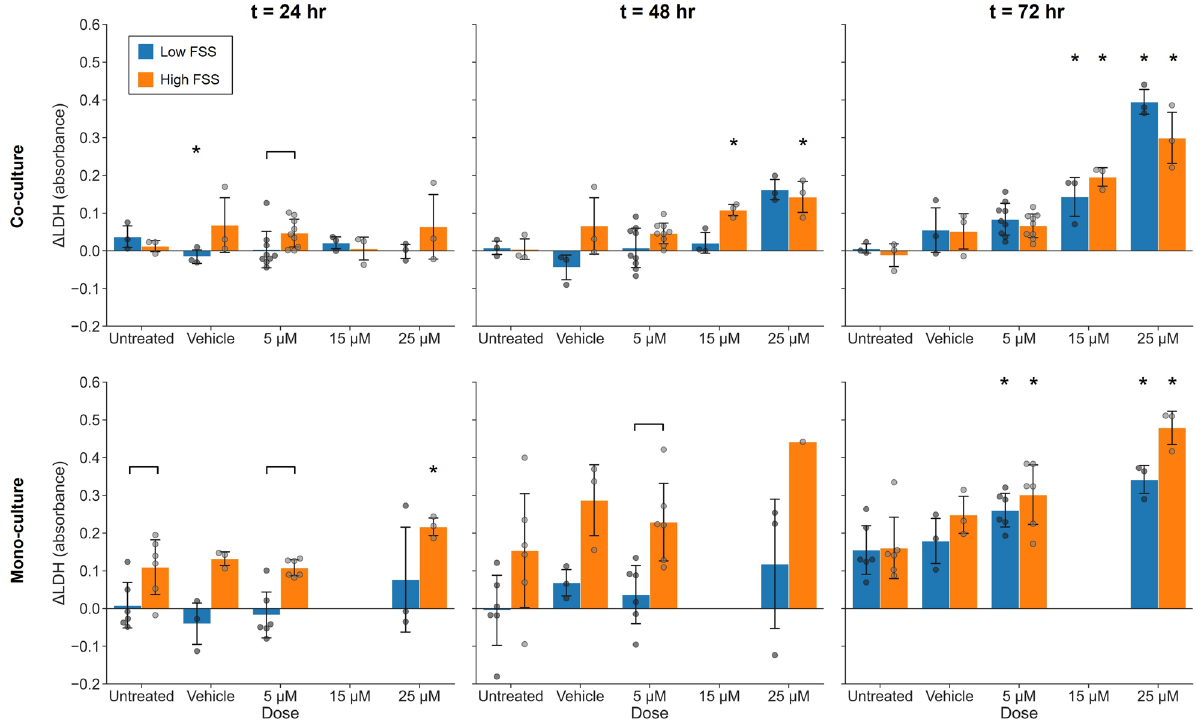
Figure 3. LDH release demonstrates dose-dependent cytotoxicity of cisplatin to the PT model. Plots show the net change in LDH release relative to baseline ( t = 0 h) at various time points during cisplatin exposure for co-cultures (top row) and mono-cultures (bottom row). LDH release remained consistent over time in untreated co-cultures conditions but increased for untreated mono-cultures. LDH release increased with cisplatin concentration and duration of exposure. Bars represent mean ± SD of biological replicates. Co-culture: n = 3 devices per condition, except 5 μM cisplatin n = 9. Mono-culture: n = 6 for untreated and 5 μM, n = 3 for vehicle and 25 μM, 15 μM not evaluated. N = 1 experimental replicate. * p ≤ 0.05 Kruskal–Wallis with Dunn’s post-hoc test compared to corresponding untreated culture control at same time point. Brackets indicate significant comparisons ( p ≤ 0.05) based on two-sided Mann–Whitney